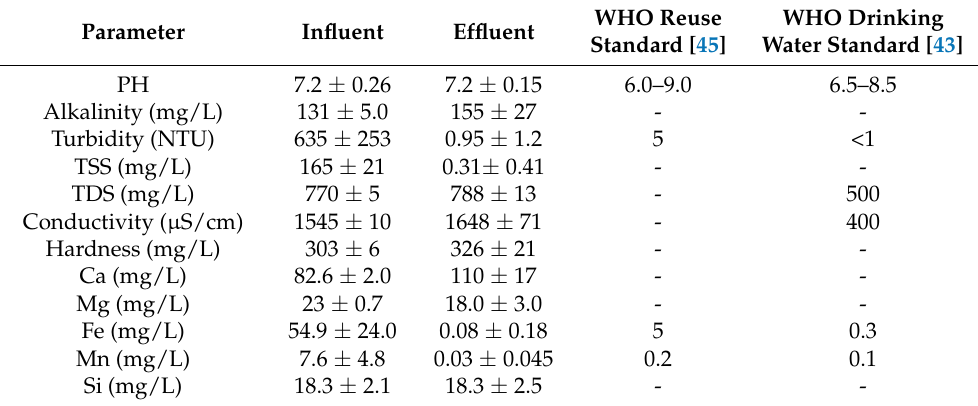
Table 4. Contaminant removal performance of low-cost clay ceramic filters compared to WHO